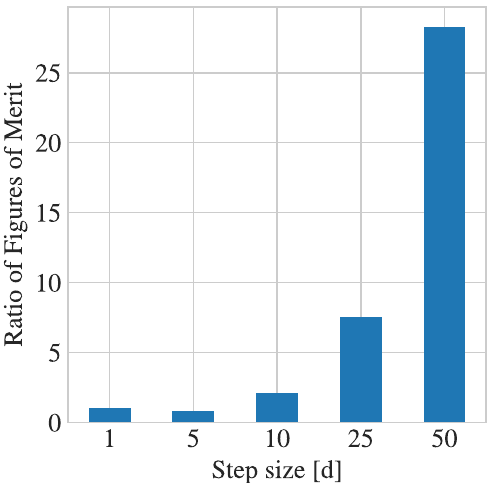
Figure 5: Ratio of custom depletion to BOS figures of